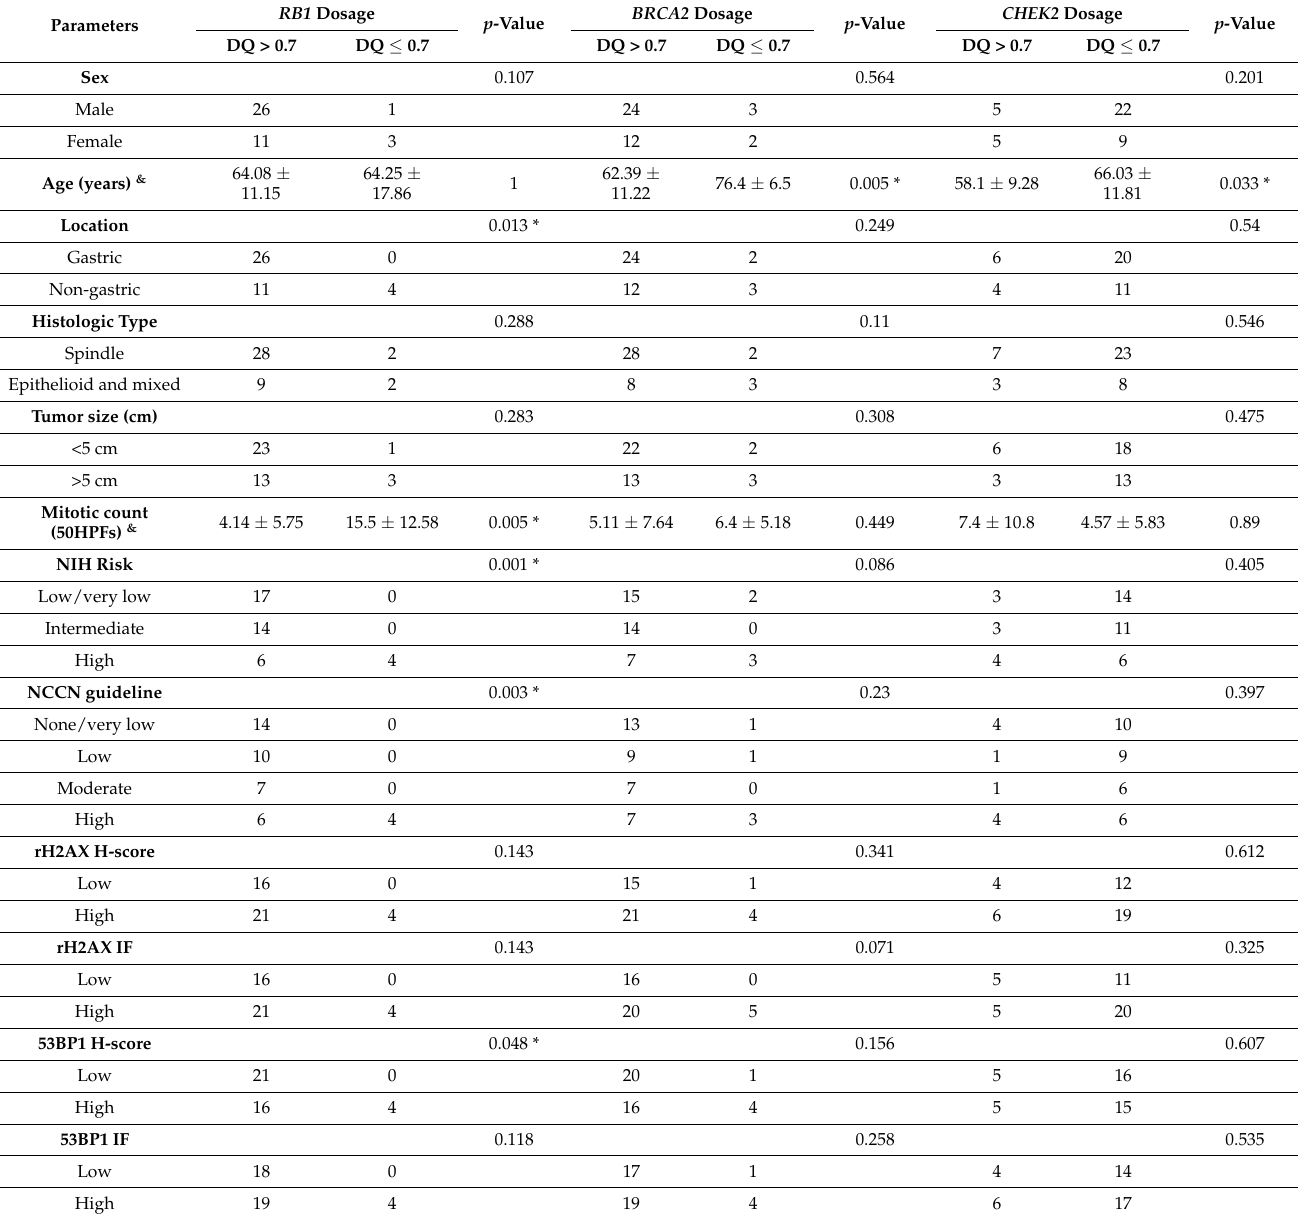
Table 2. Associations of RB1, BRCA2, and CHEK2 gene dosages with various clinicopathologic